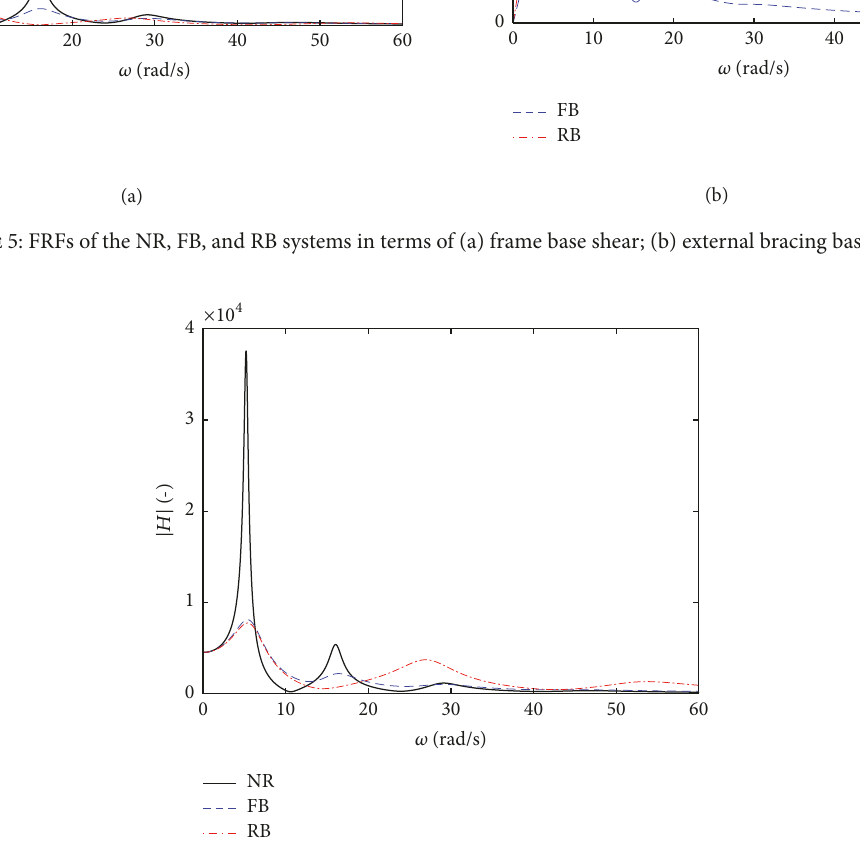
Figure 6: FRFs of the NR, FB, and RB systems in terms of total base